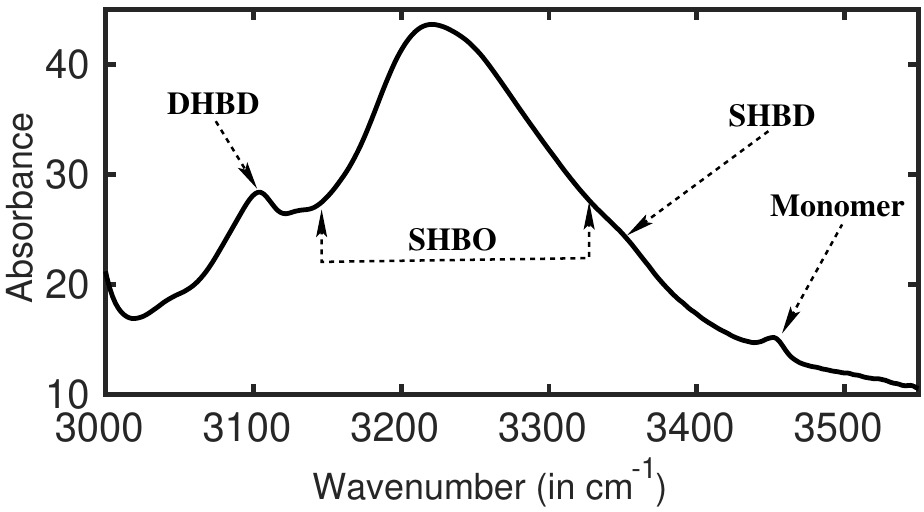
Figure 8. 1D absorption spectra (FTIR) of 2-Pyrrolidinone in carbon tetrachloride is collected at the amide A spectral region.